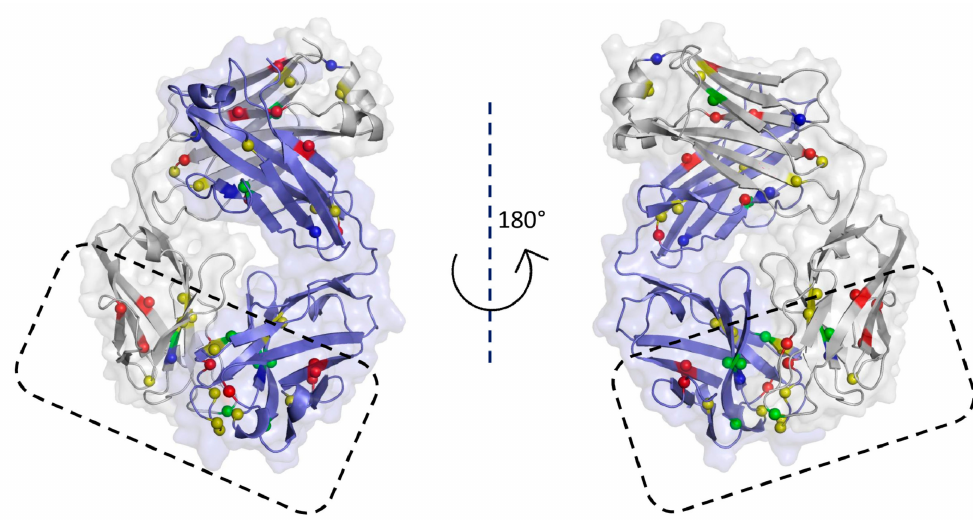
Figure 4. Cetuximab Fab: spheres indicate the location of Tyr (yellow), Trp (green), Phe (red), and His (blue) residues that were mutated into Gly and Ala. The contact area with the receptor, enclosed by a box, was not considered in this